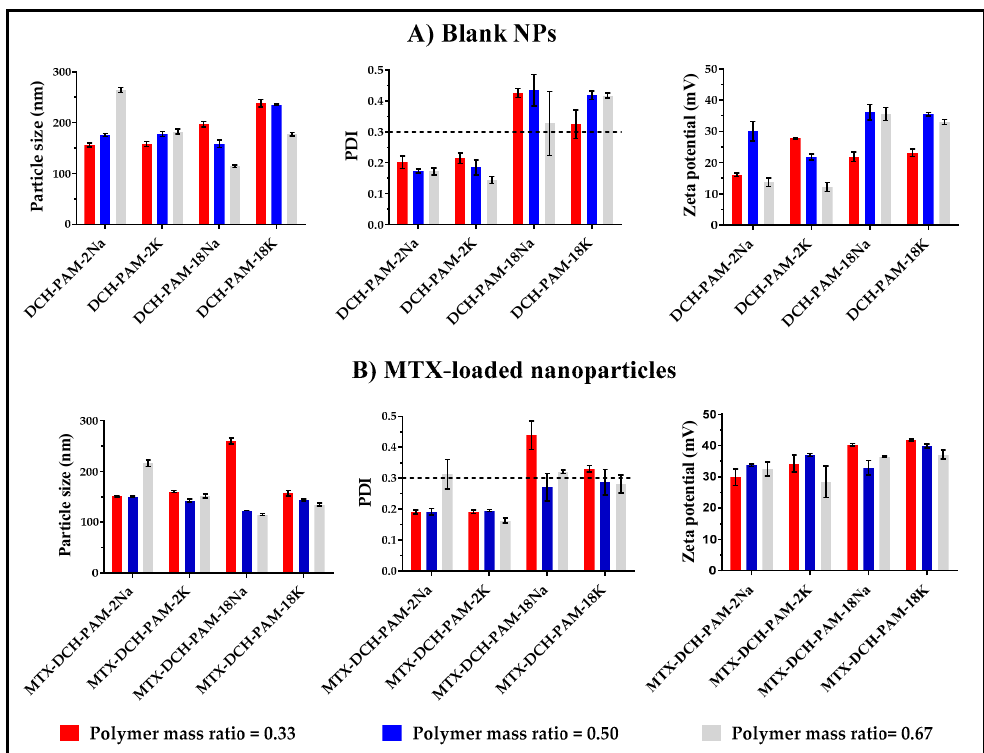
Figure 2. Particle size, polydispersity index-PDI and zeta potential characterization of ( A ) blank NPs and ( B ) MTX-loaded NPs in different mass ratios with chitosan.